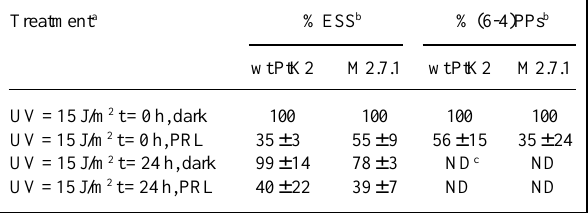
Table I - DNA repair of CPDs (ESS) and (6-4)PPs in PtK2 (wt) and M2.7.1 cells.